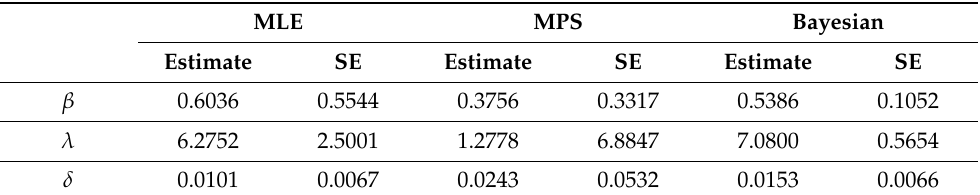
Table 5. MLE, MPS, and Bayesian estimation methods for parameters of WE distribution under PTIICS for real data.